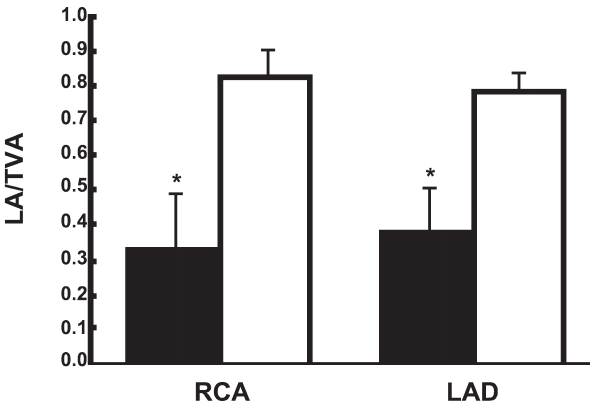
Figure 3b - LA/TVA ratio for the right coronary artery (RCA; left) and left anterior descending artery (LAD; right) of patients (filled columns) and controls (open columns). The reduced ratio for patients with coronary artery disease was due to vessel enlargement.